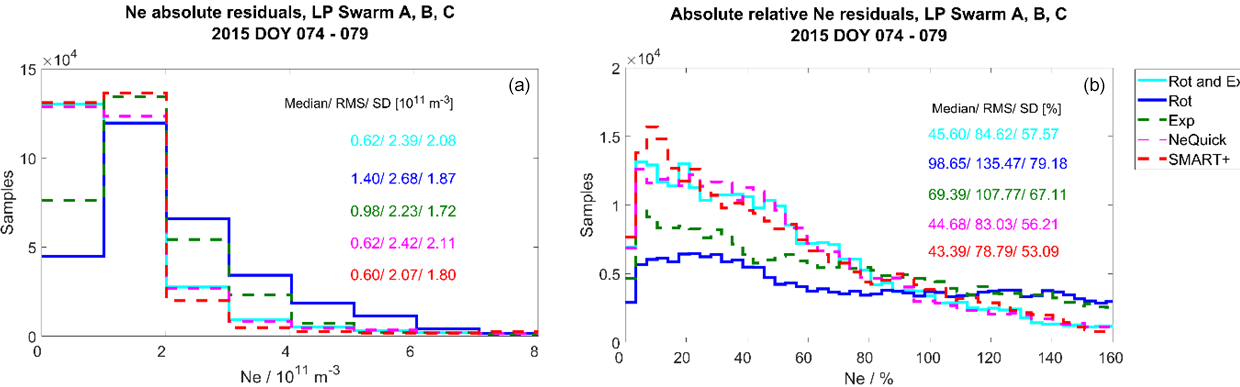
Figure 20. Validation with LP data. Distribution of the Swarm absolute and absolute relative electron density residuals for the perturbed